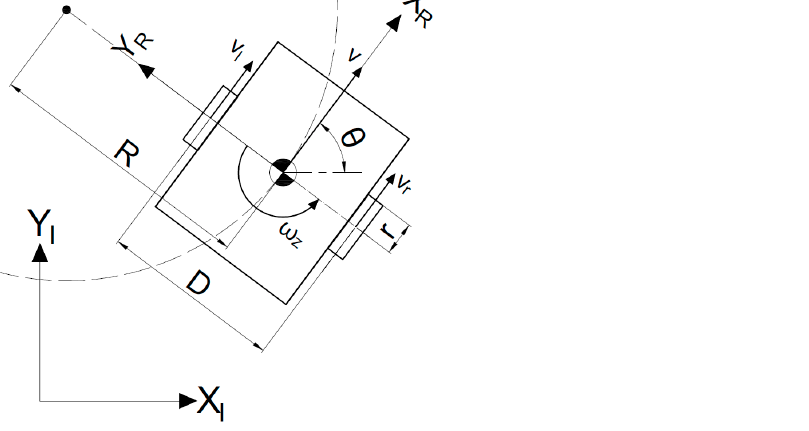
Figure 1. The differential drive mobile robot.